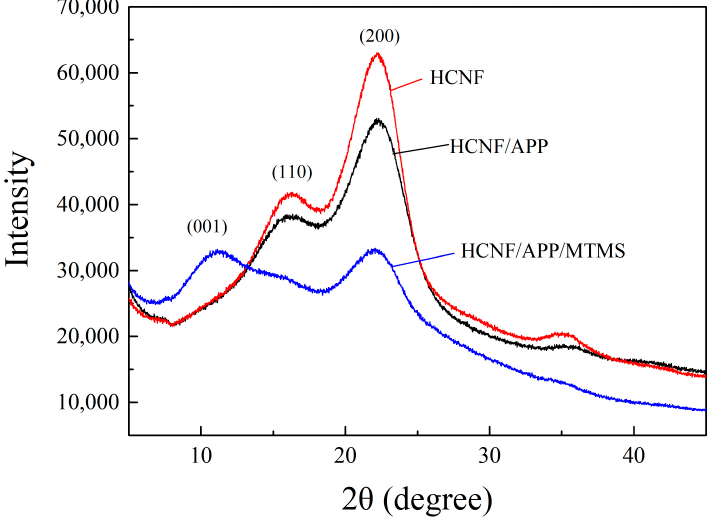
Figure 4. The XRD pattern of HCNF, HCNF/APP, and HCNF/APP/MTMS aerogels. The TGA and DTA curves of HCNF, HCNF/APP, and HCNF/APP/MTMS aerogels are shown